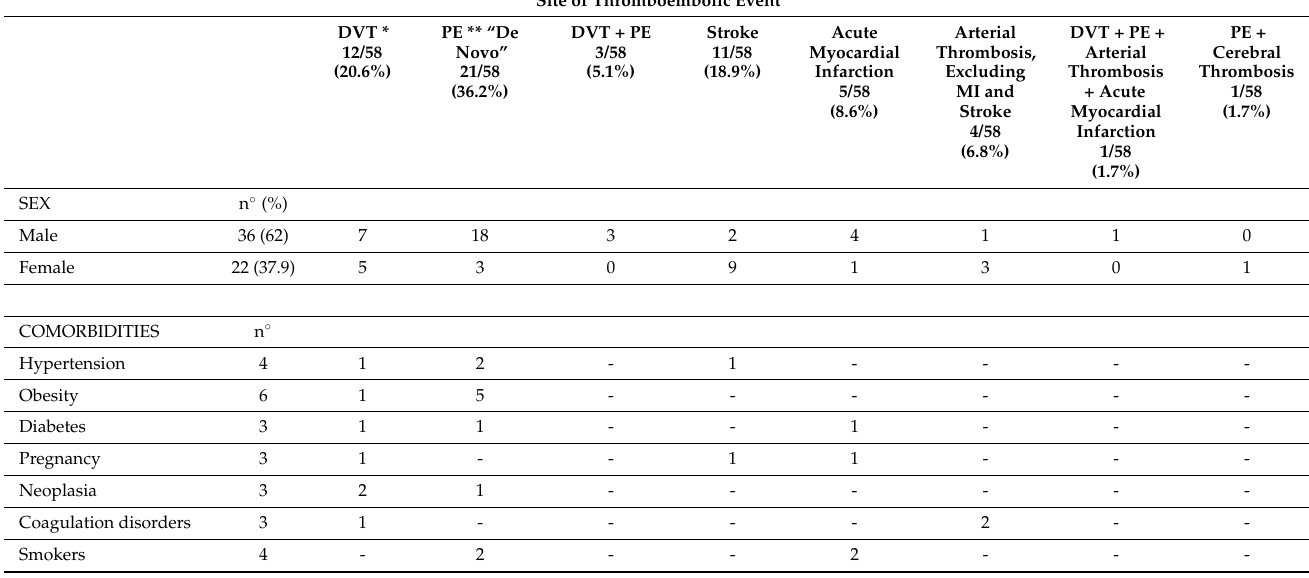
Table 2. Comorbidities and sites of thromboembolic events in the study